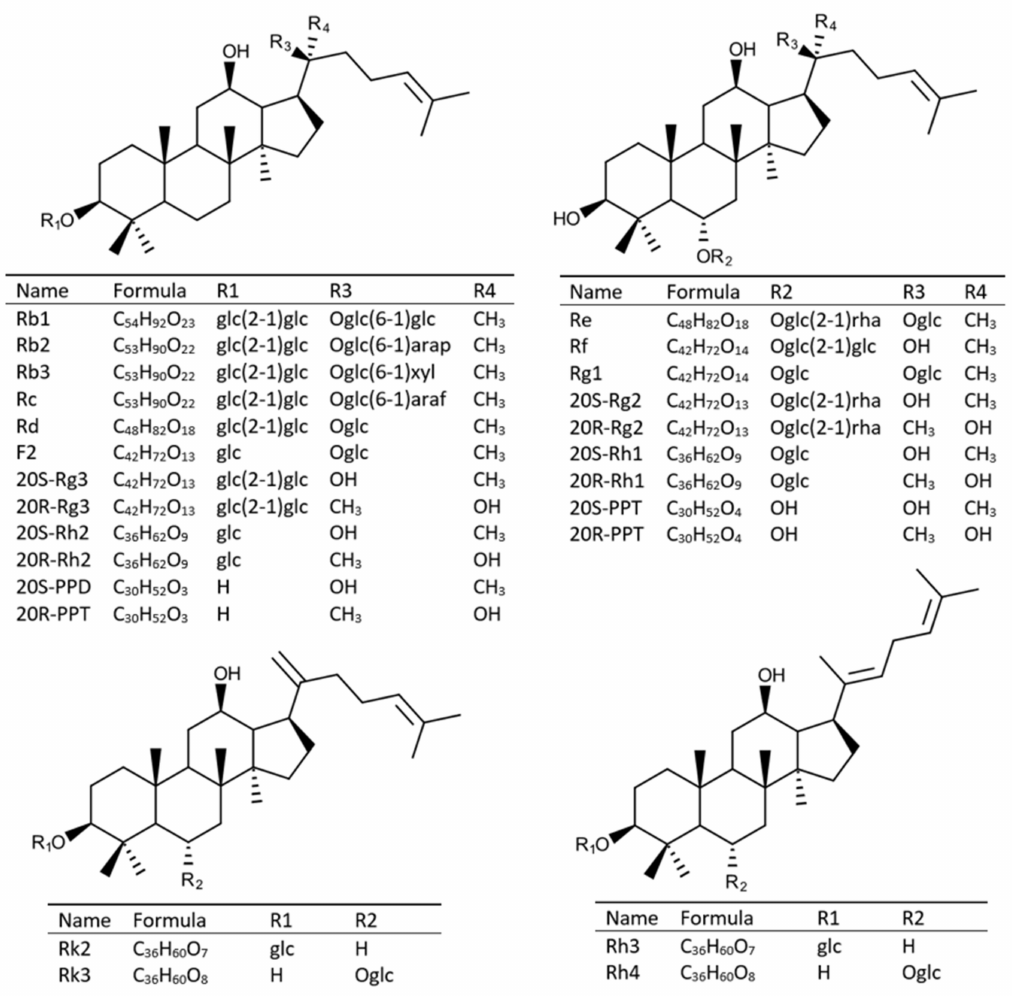
Figure 1. The chemical structures and molecular formulas of reference standards in this study. The glc, arap, xyl, araf, and rha refer to β -D-glucopyranosyl, α -L-arabinopyranosyl, β -D-xylopyranosyl, α -L-arabinofuranosyl, and α -L-rhamnopyranosyl,